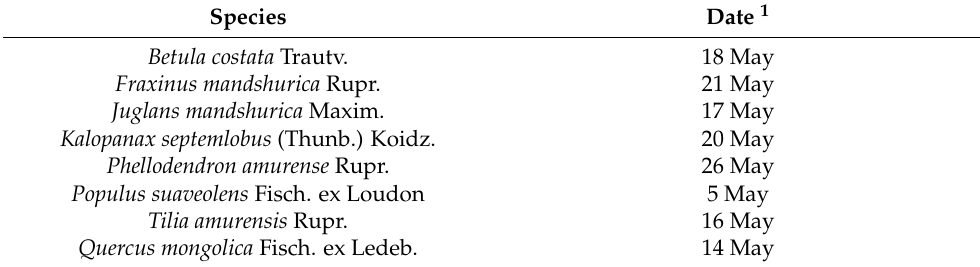
Table A1. Common dates of emergence of leaves (full leaf) on main deciduous tree species*.